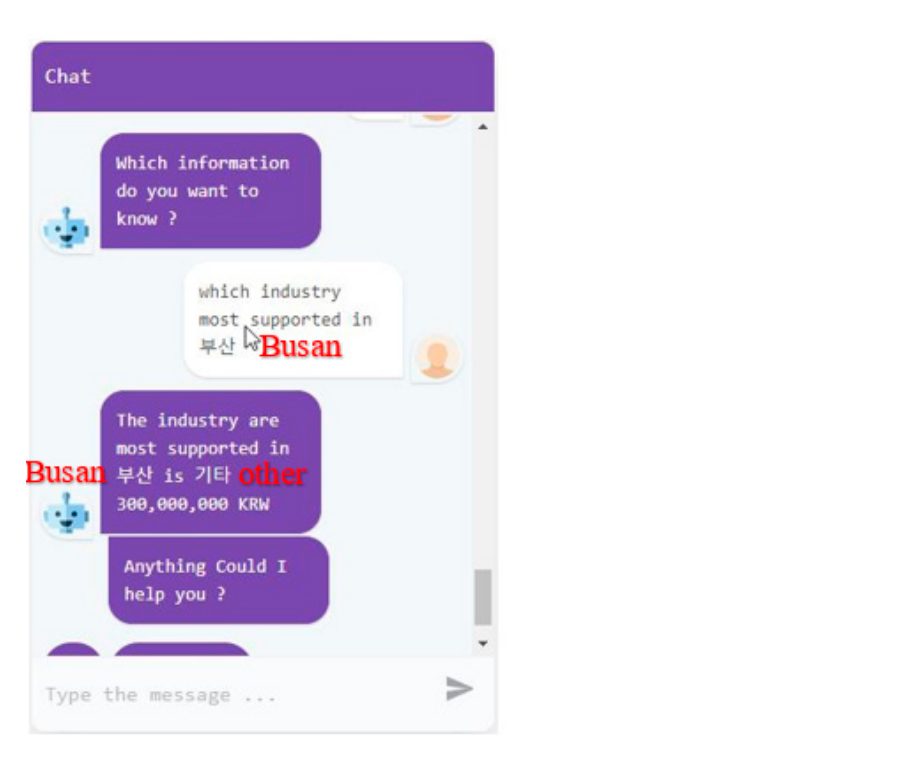
Figure 27. Assistant Application answering the question on the industry most supported in Busan.